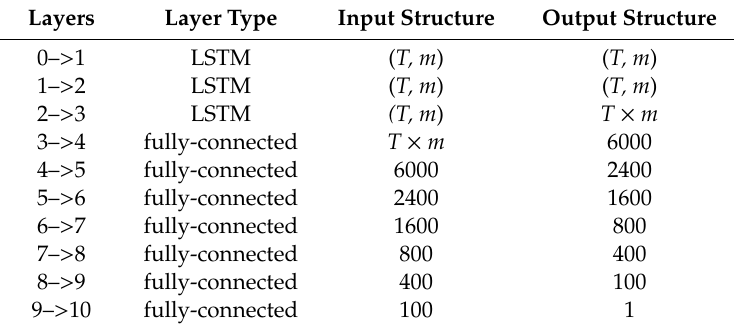
Table 4. The architecture of LSTM with hourly input